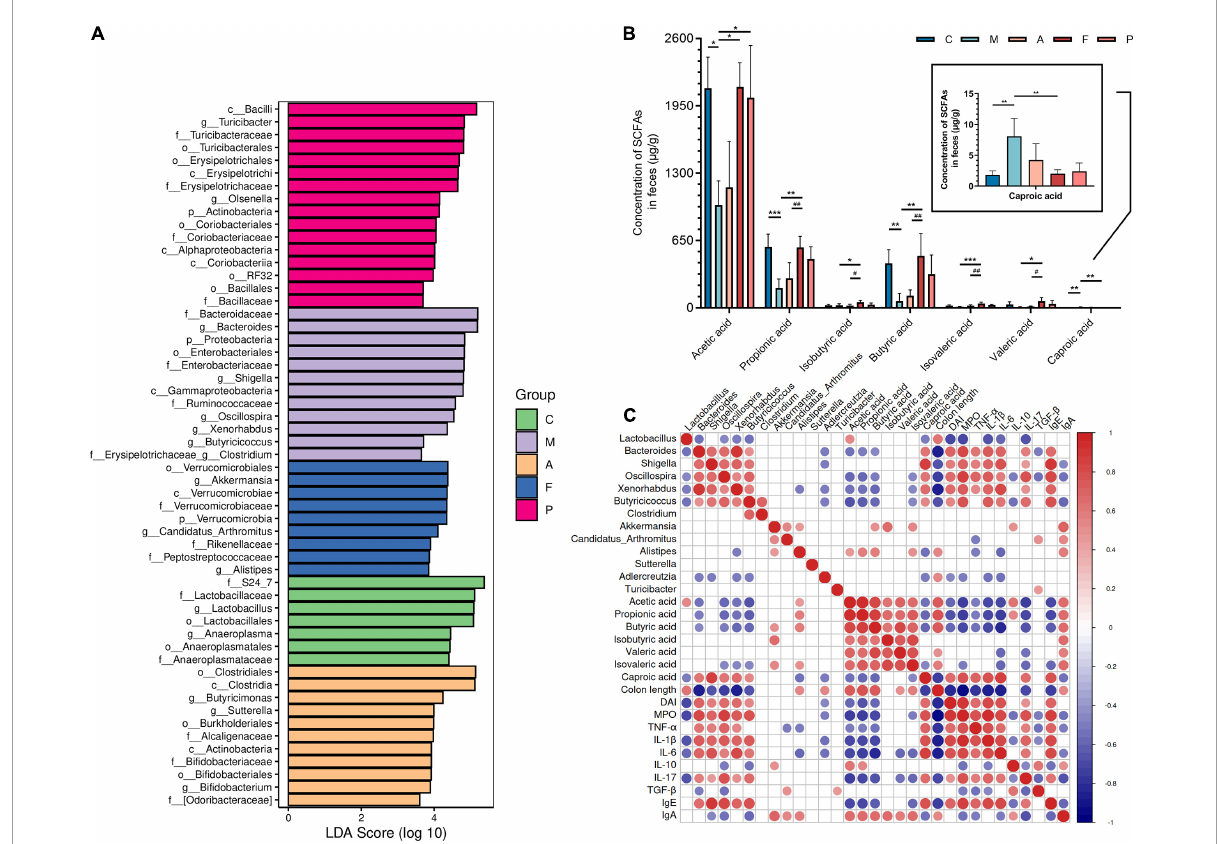
FIGURE4 Key microbial communities characteristics and function of gut microbiota: (A) analysis of differences in the microbiota shown by LEfSe (linear discriminant analysis effect size); (B) the content of acetic acid, propionic acid, butyric acid, isobutyric acid, valeric acid, isovaleric acid and caproic acid in feces of DSS-induced mice; (C) correlation between key microbes, short chain fatty acids and parameters of colitis. Data are mean ± SD ( n = 4). * P ≤ 0.05, ** P ≤ 0.01, and *** P ≤ 0.001 vs. the M group; # P ≤ 0.05 and ## P ≤ 0.01 vs. the A group. The red color denotes a positive correlation, while blue color denotes a negative correlation. The intensity of the color is proportional to the strength of Spearman correlation.